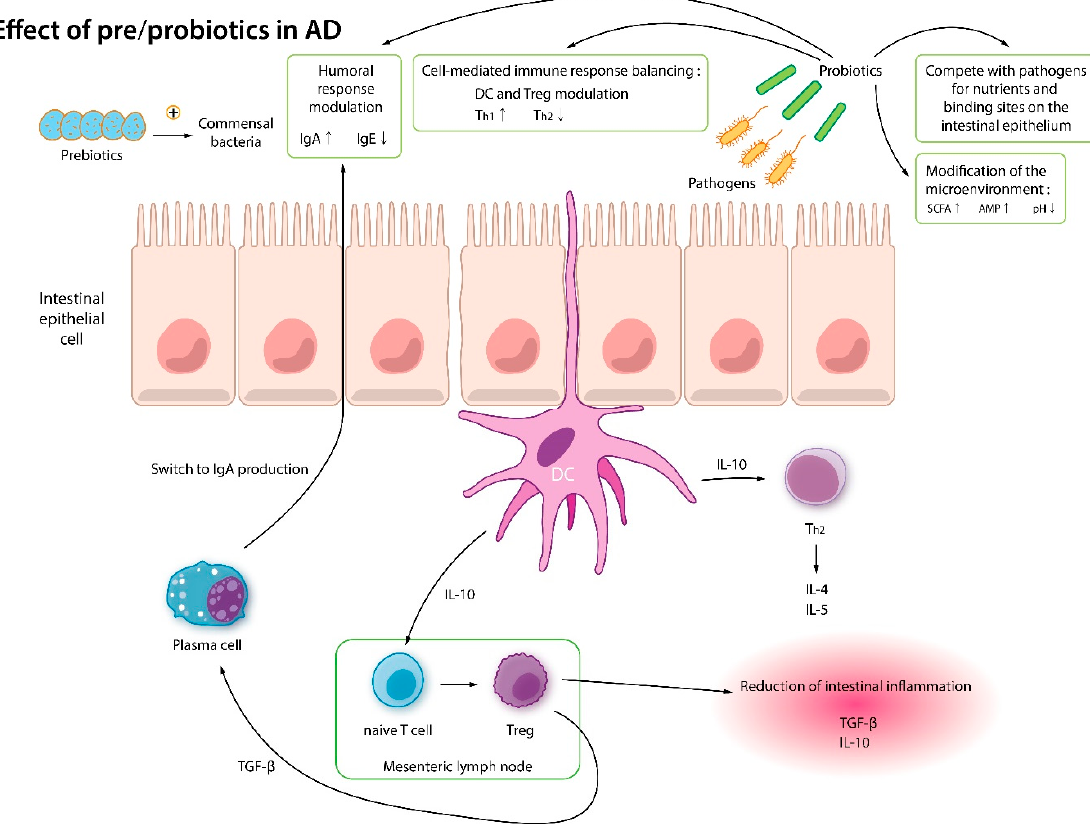
Figure 4. Immune mechanisms of pre- and probiotics. Prebiotics feed the commensal bacteria and protiotics. Probiotics modulate the humoral response (increase IgA and decrease IgE), balance cell-mediated immune response (increase Treg cells and decrease Th2 response), compete with pathogens, and modify the microenvironment. SCFA: short chain fatty acid; AMP: anti-microbial peptide; DC: Dendritic cell; IL: Interleukin; TGF: Tumor growth factor; IgE: Immunoglobulin E; IgA: Immunoglobulin A; Th1: T helper 1 cells; Th2: T helper 2 cells.